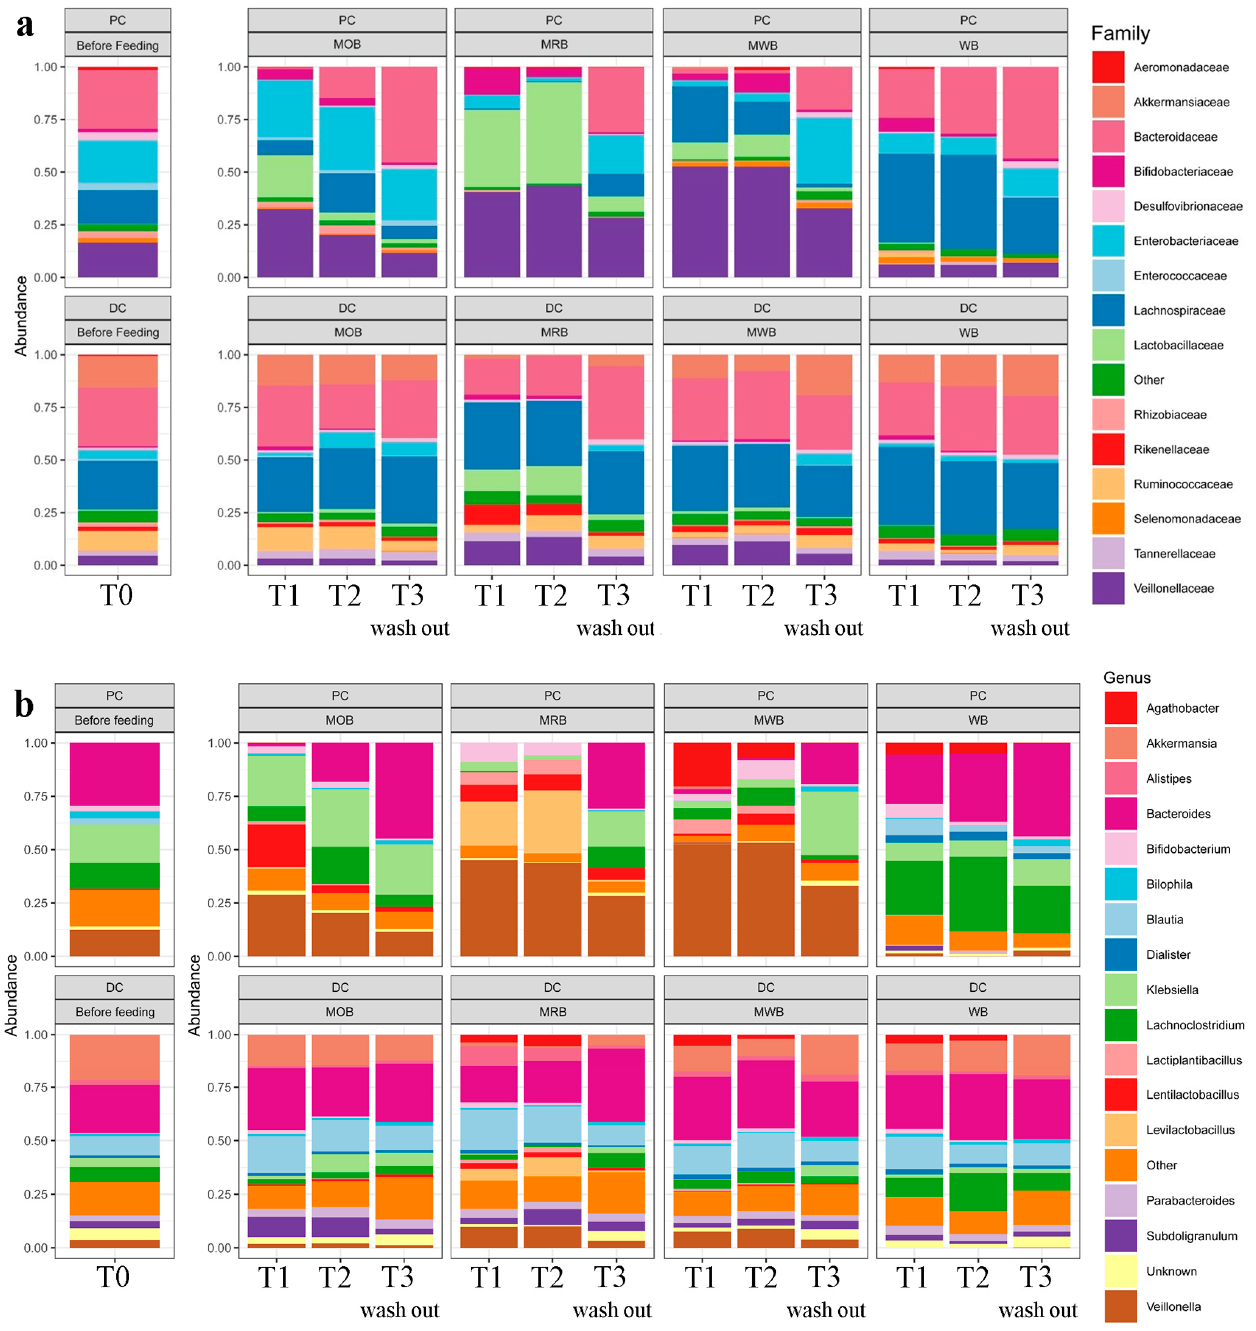
Figure 3. Relative abundance at family (panel a ) and genus (panel b ) level of the bacterial microbiota, before (T0), during one (T1) and two (T2) weeks of feeding with MOB, MRB, MWB and WB, and after two weeks of wash out period (T3), in the PC and DC tracts.